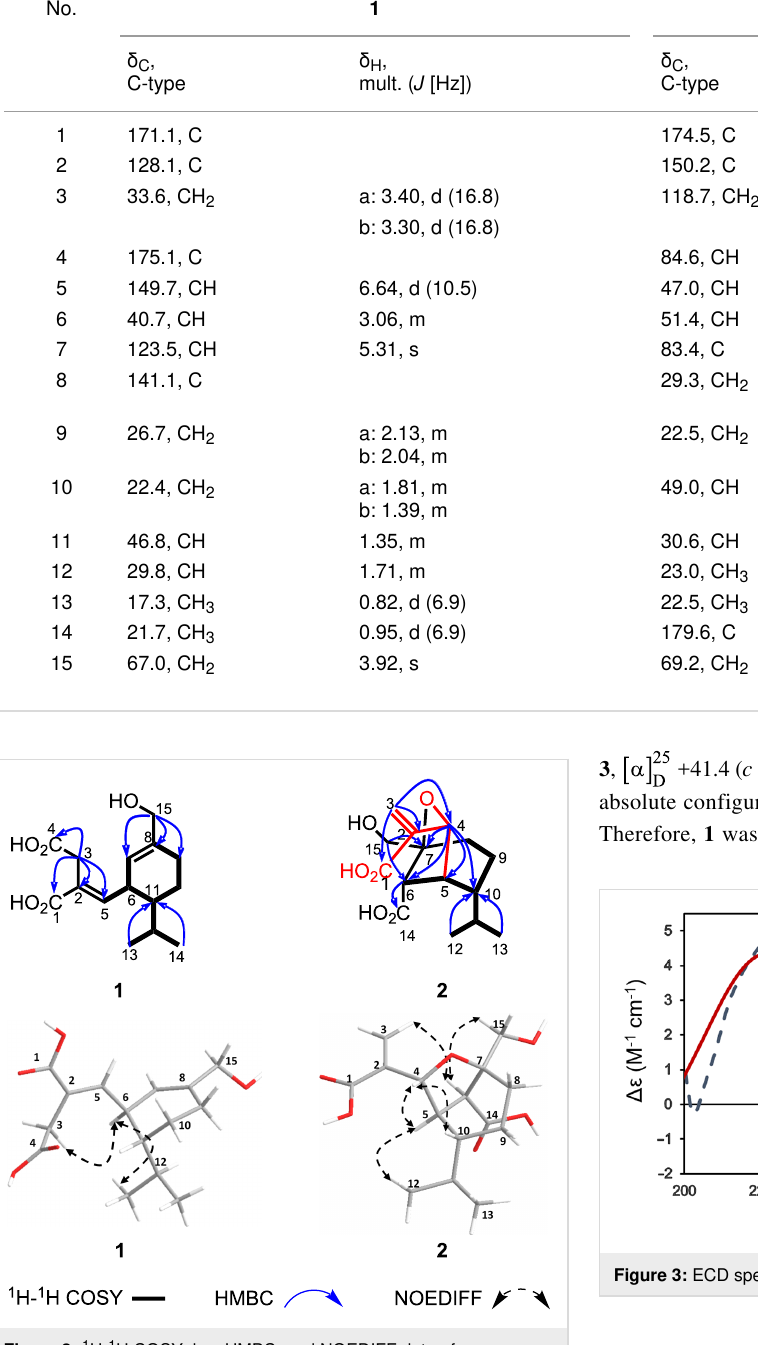
Trichocitrinovirene B ( 2 ) was isolated as a colorless gum. The molecular formula C 15 H 22 O 6 was determined on the basis of the HRESIMS peak at m / z 321.1320 [M + Na] + . The IR spec- trum was similar to that of compound 1 , indicating that they possessed similar functional groups. The 1 H NMR spectrum (Table 1) displayed characteristic signals for two geminal olefinic protons ( δ H 5.93 and 5.52, each s, 1H), one oxyme- thine proton ( δ H 4.72, s, 1H), three methine protons ( δ H